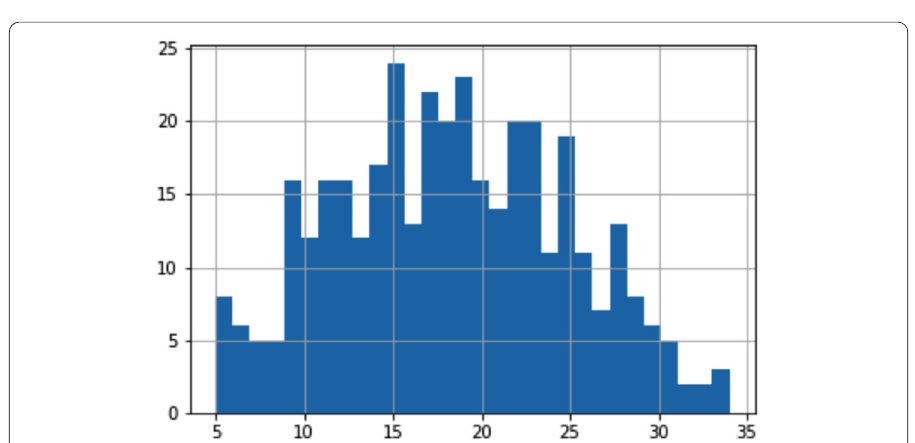
Figure 1 Distribution of SWSL